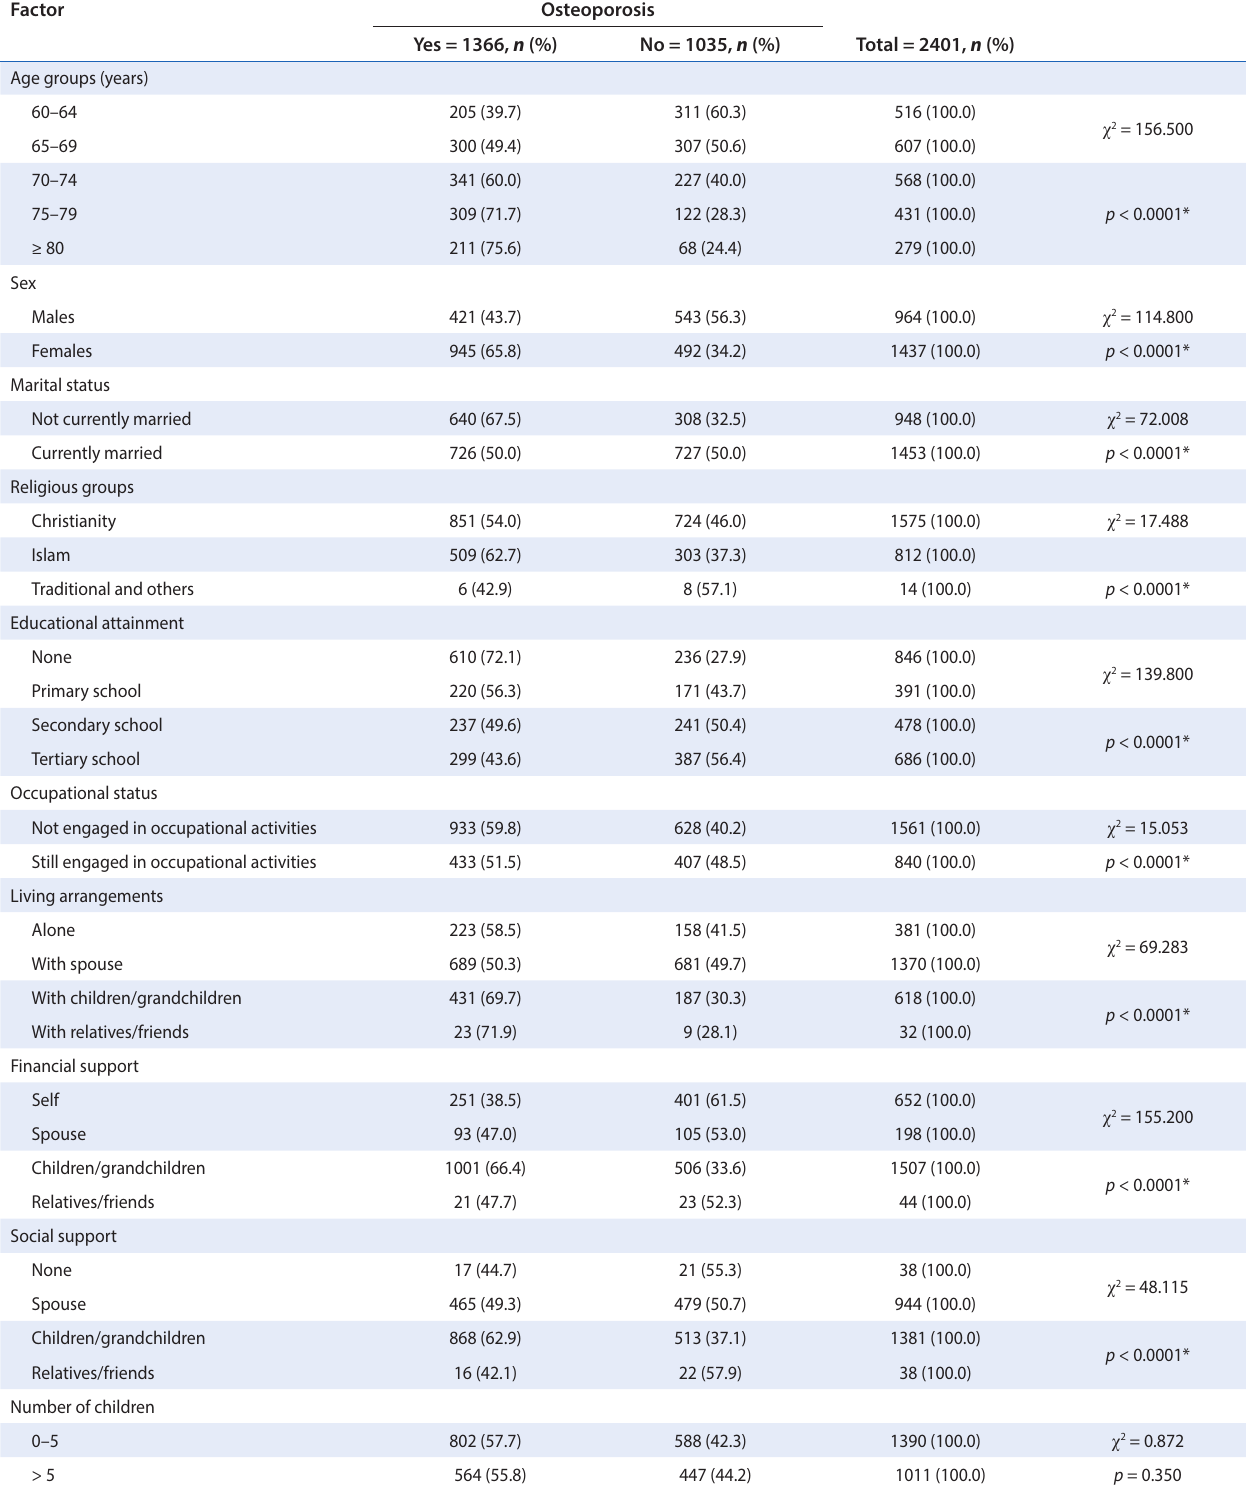
*Significant at 5% level of